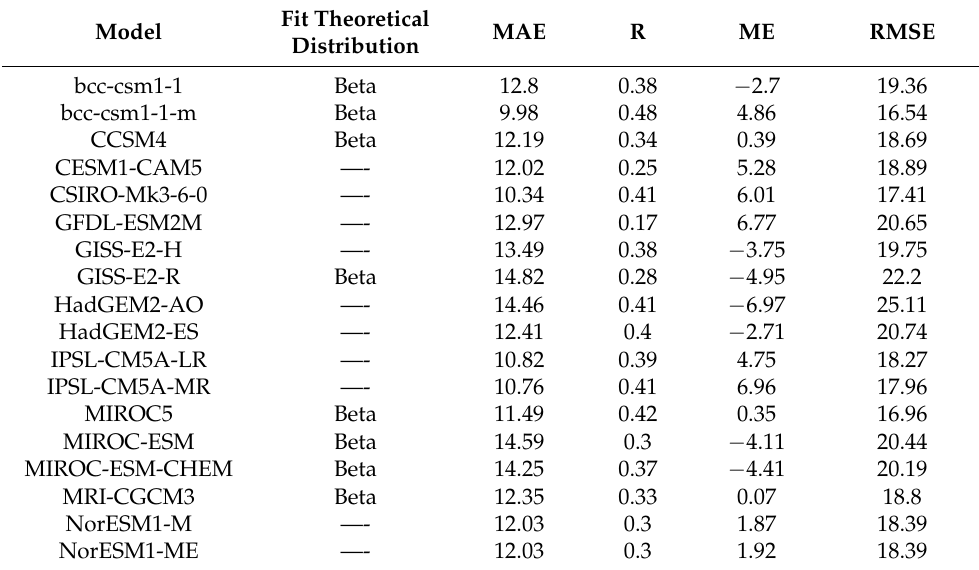
Table 3. GOFs of CMIP5 monthly areal average rainfall models against observed data.